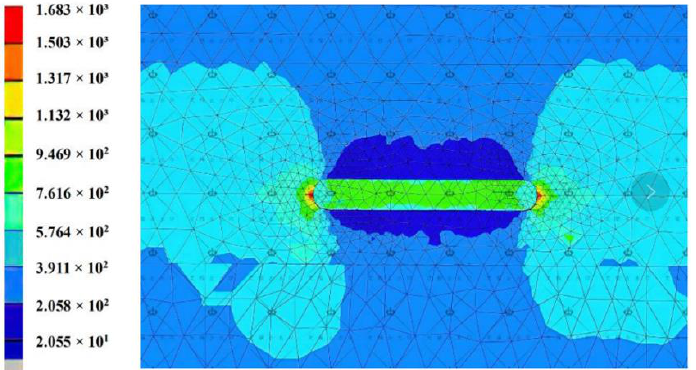
Figure 19. Stress nephogram of precast notch.